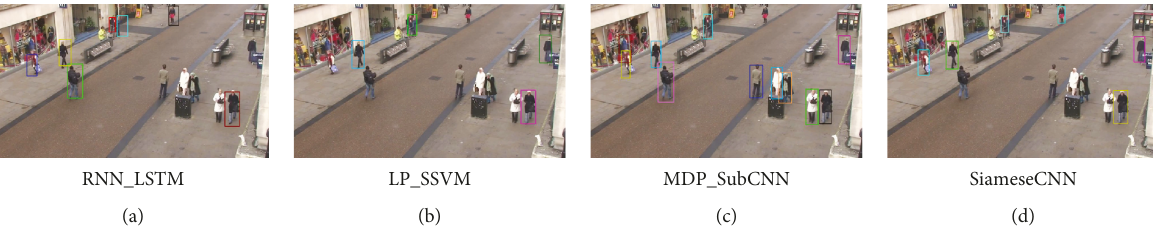
Figure 14: Sample tracking results of other trackers on frame number 405 of AVG-TownCentre.